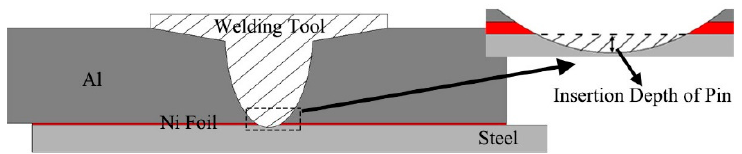
Figure 1. A schematic diagram of welding process. Table 2. Process description and tensile fracture load for FSLW steel/Al.